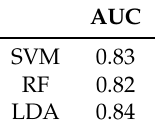
Table 4. Area Under Curve (AUC) for each model in WM/PR